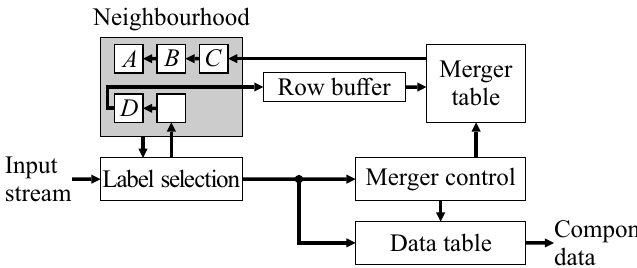
Figure 1. Basic architecture of single-pass connected components